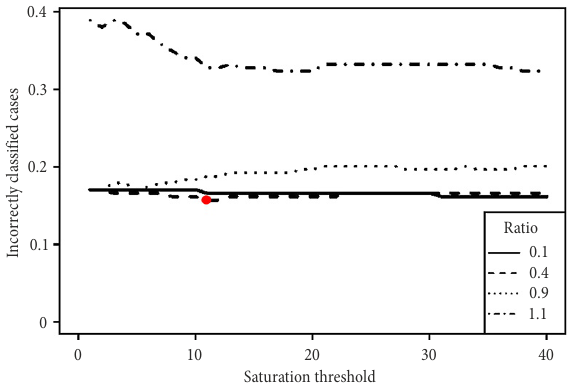
Fig. 2. Cross-validation test error for a range of parameter values of the automatic English version